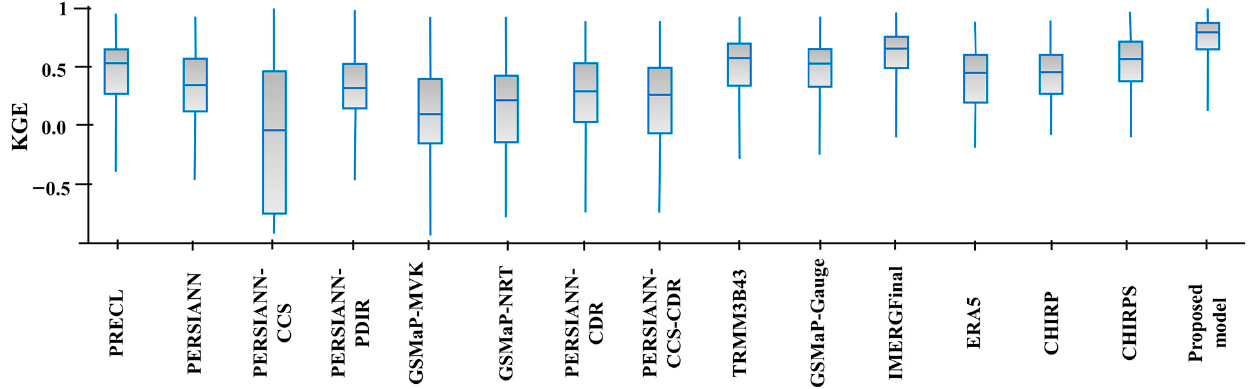
Figure 5. Box-plot of KGE values for the study area within 2003–2021 obtained from pixel-to-pixel assessment strategy.